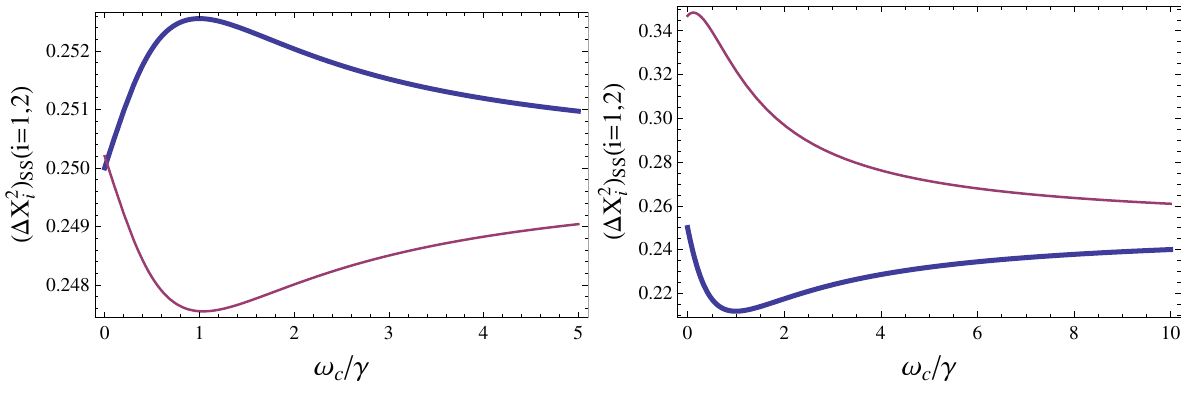
/γ for U = 0 . 01 γ and α = 0 . Right c 0 (thin 2